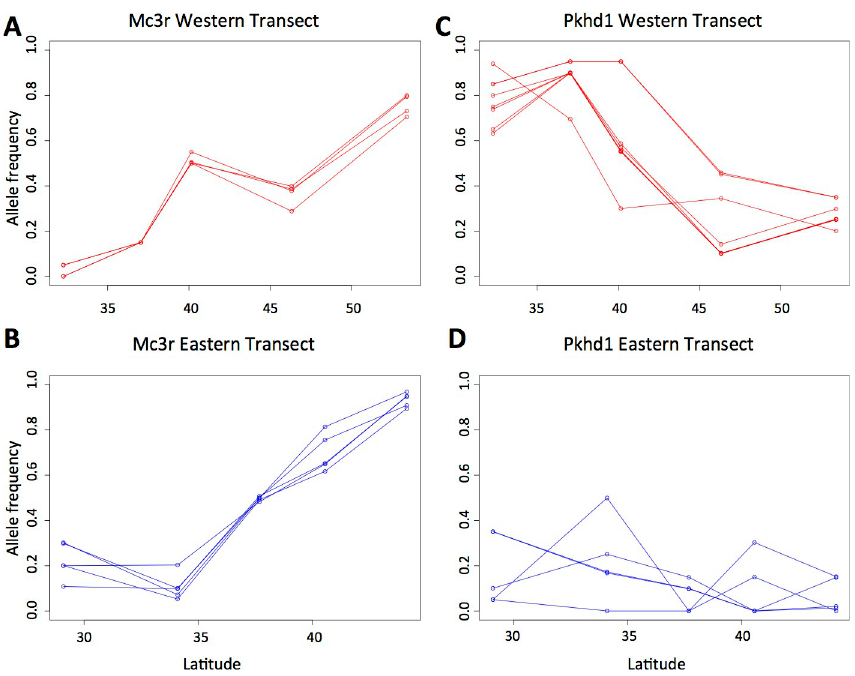
Fig 5. Examples of concordant and discordant clinal patterns between the eastern and western transects. Allele frequency changes at SNPs in Mc3r are similar in the western (A) and eastern (B) transects, while allele frequency changes at SNPs in Pkhd1 are different in the western (C) and eastern (D) transects. Mc3r is believed to be involved in body size variation, while Pkhd1 is involved in kidney function.